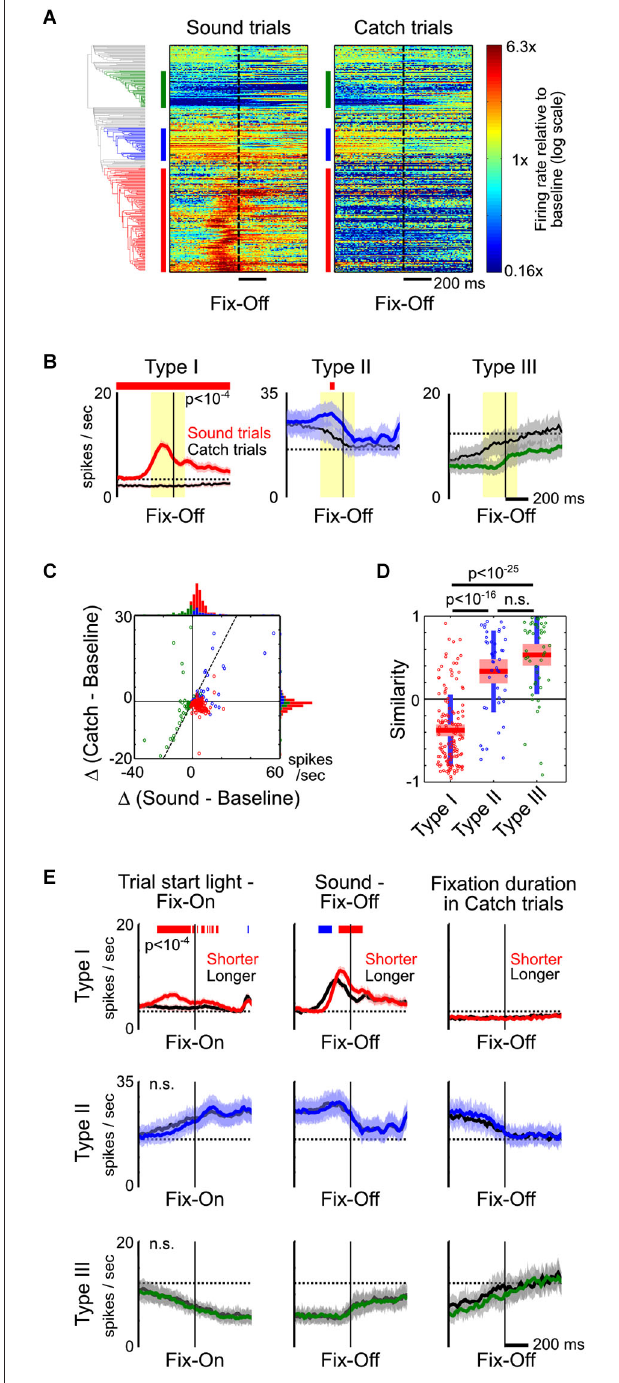
FIGURE 4 | Type-II and III BF neurons reflect fixation and movement states. (A) PSTHs of all individual BF neurons to fixation port exit (Fix-Off) in sound trials and catch trials, with response amplitude normalized by their respective baseline firing rates. While the response of Type-I BF neurons were the opposite in sound and catch trials, the responses of other neurons were highly similar when animals exited the fixation port, irrespective of whether the exit response was prompted by a